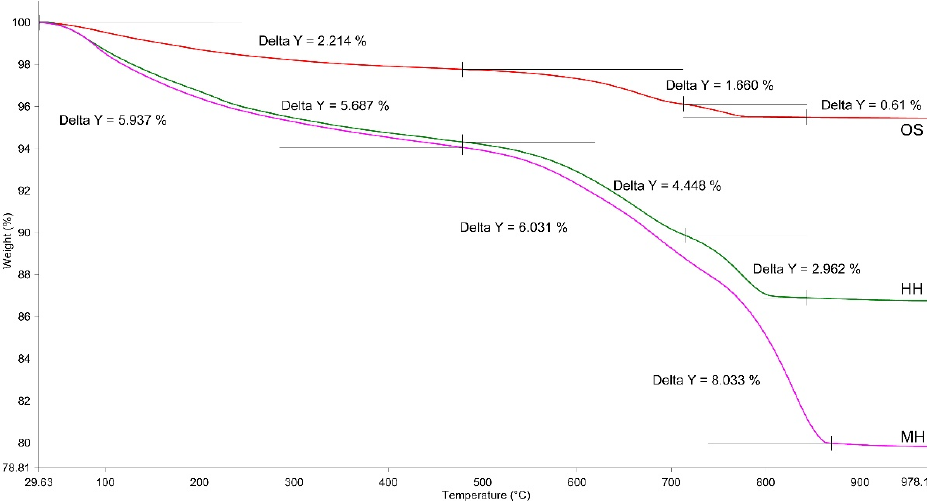
Figure 5. Results of the TG-DSC analysis of the HH ( a ) and MH ( b ) samples.